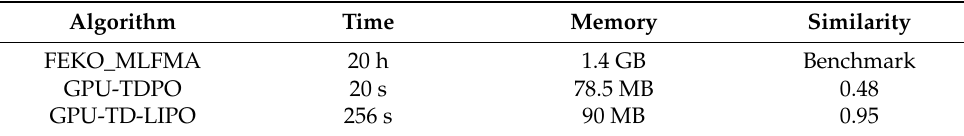
Figure 16. Normalized ISAR images of the dihedral angle under different methods. ( a ) TDPO; ( b ) TD − LIPO; ( c ) FEKO_MLFMA. Table 3. Time and similarity of each method.